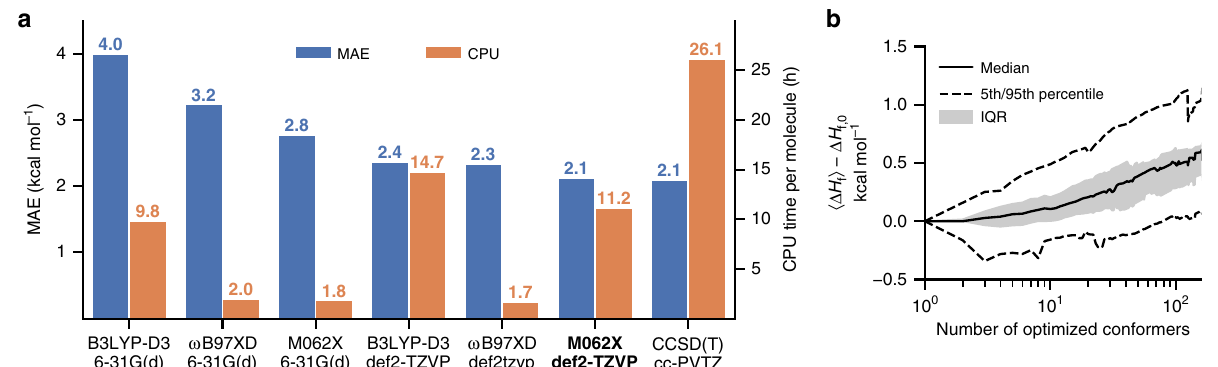
Fig. 1 Benchmark study of DFT methods. a Trade-off between accuracy (left axis, blue) and computational cost (right axis, orange) for a selection of common QM methods. M06-2X/def2-TZVP was selected for subsequent calculations. MAE and CPU time were averaged over 368 different bonds. b Effect of conformer sampling. Molecules were optimized with MMFF94s, and the lowest-energy conformers were used to initialize DFT calculations. The plot shows the difference between the Boltzmann average enthalpy for the entire ensemble and the DFT-calculated enthalpy of the fi rst conformer as a function of the number of optimizations performed. Exhaustive conformer sampling only changes the median resulting enthalpies by <0.5 kcal mol − 1 , with a relatively narrow inner-quartile